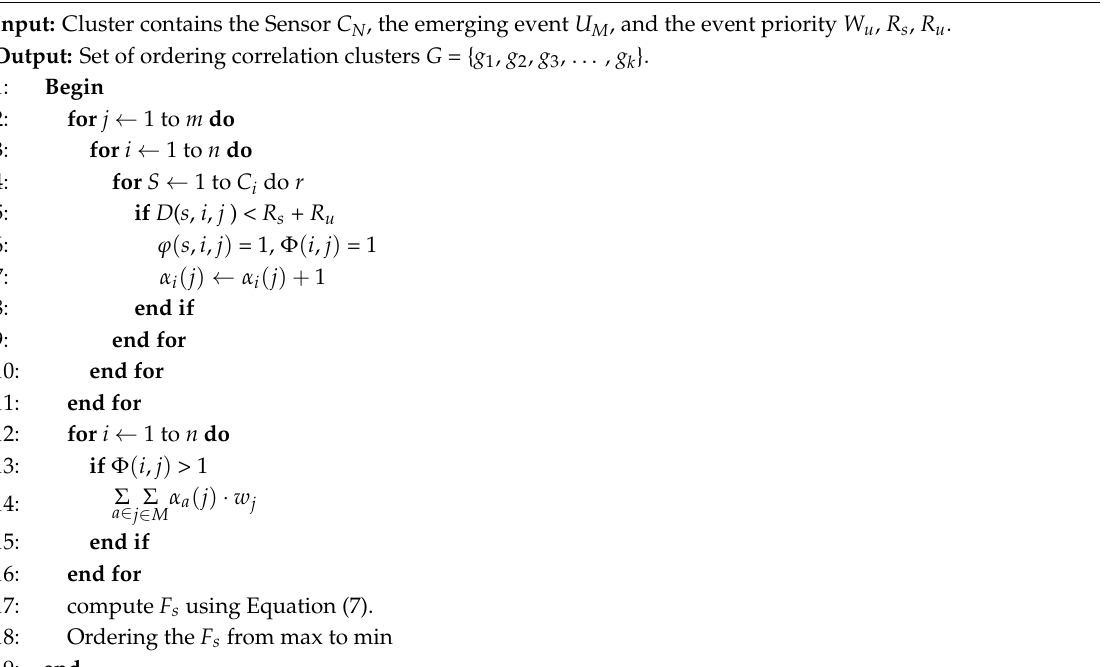
Algorithm 1. Based on the correlation of the flying sequence for multiple emerging